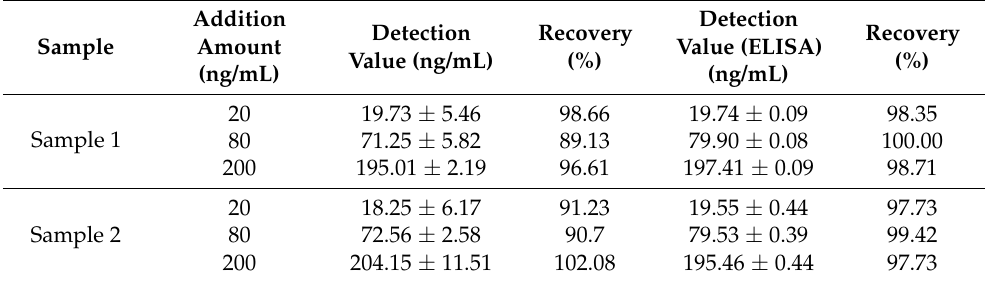
Table 1. Comparison of the detection results of FB 1 in corn samples between FRET and the ELISA.